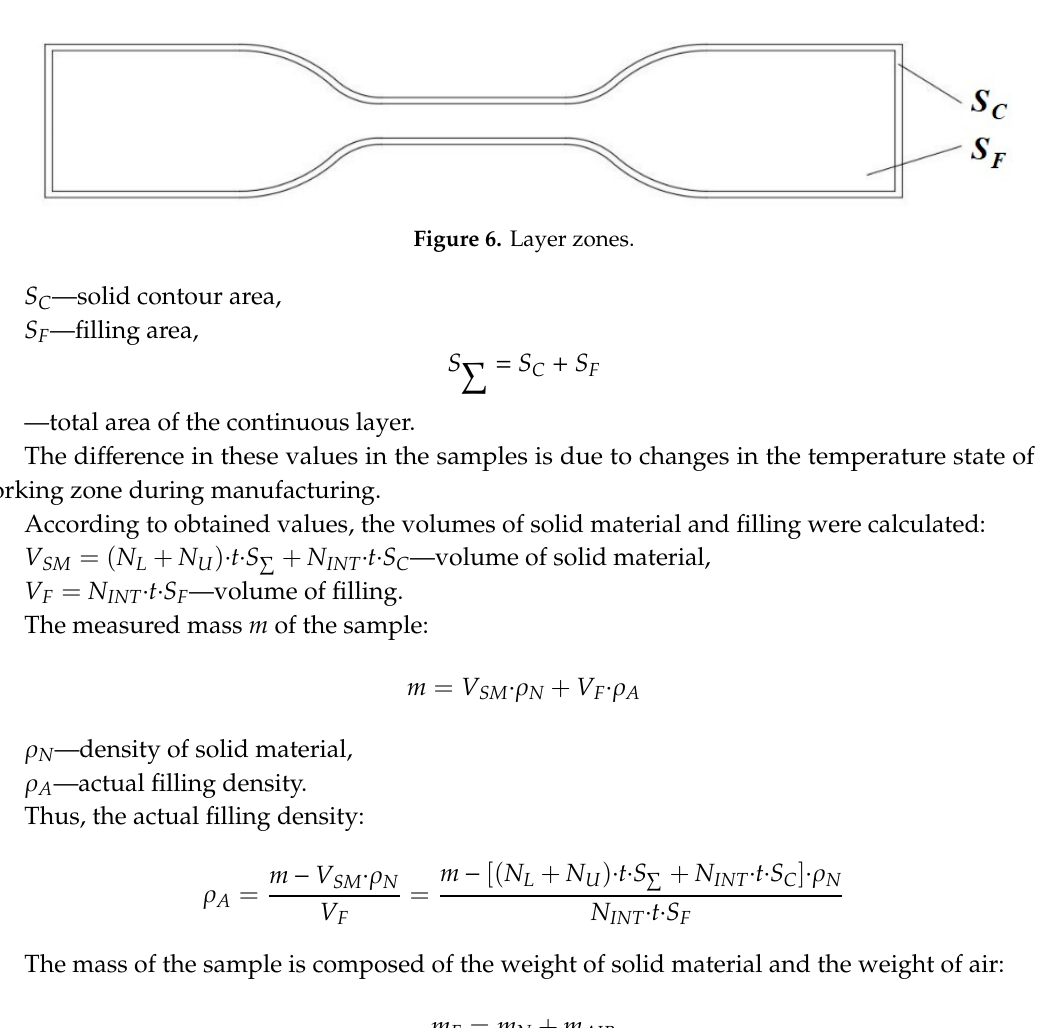
Figure 5. Infill scheme of upper and lower layers ( a ); infill scheme of intermediate layers ( b ).